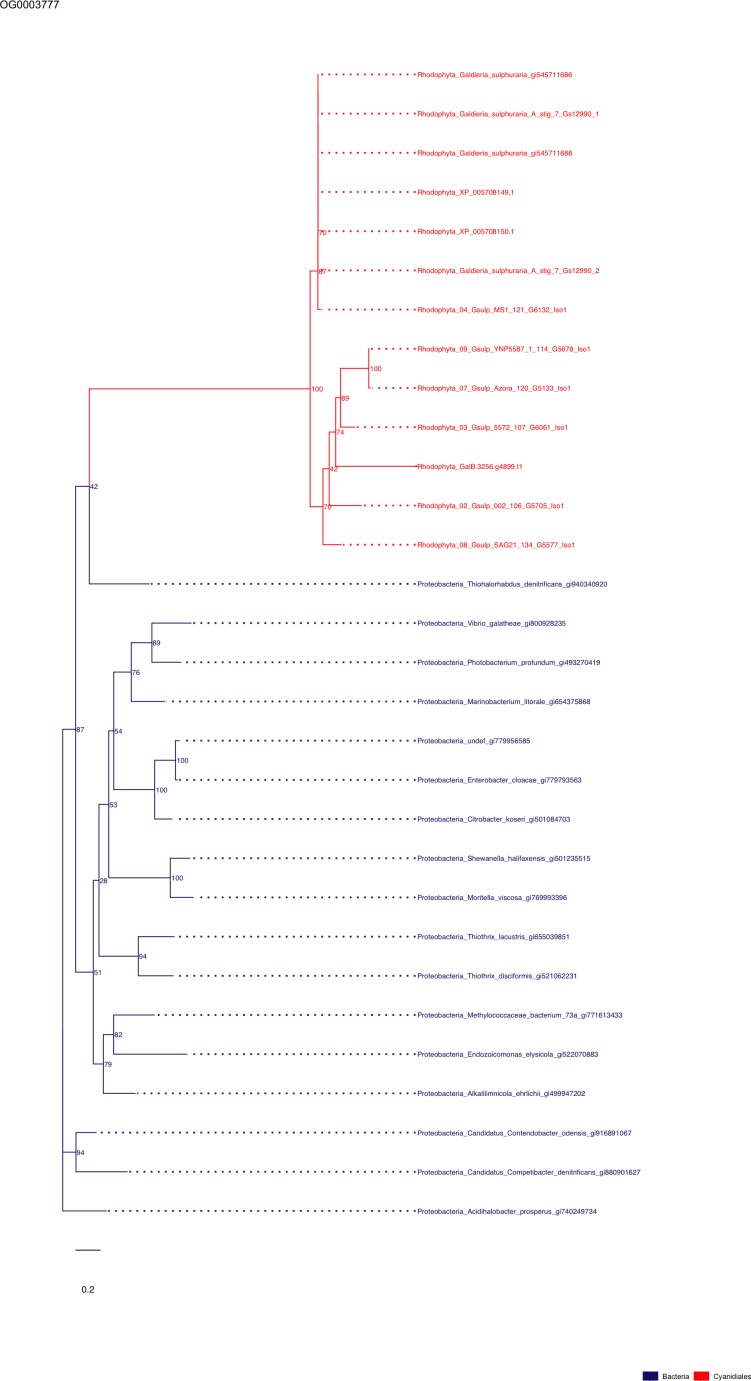
Sequence tree of orthogroup OG0003777.The tree is based on amino acid sequences. Archaea (yellow), Bacteria (blue), Cyanidiales (red), Eukaryotes including other red algae (green). Branches containing Cyanidiales sequences are highlited in red.